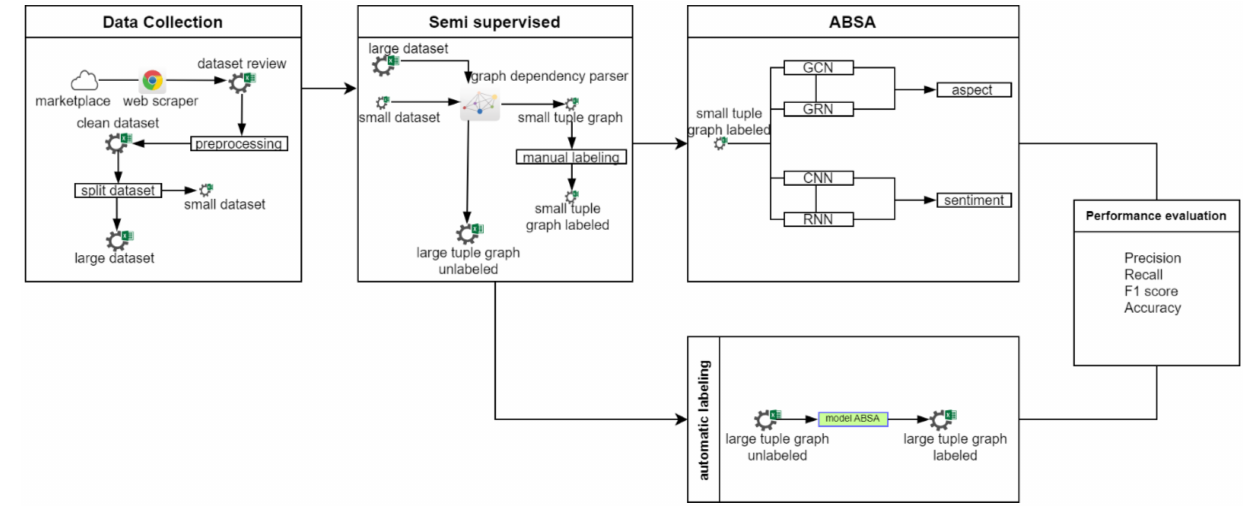
Figure 1. Research methods.